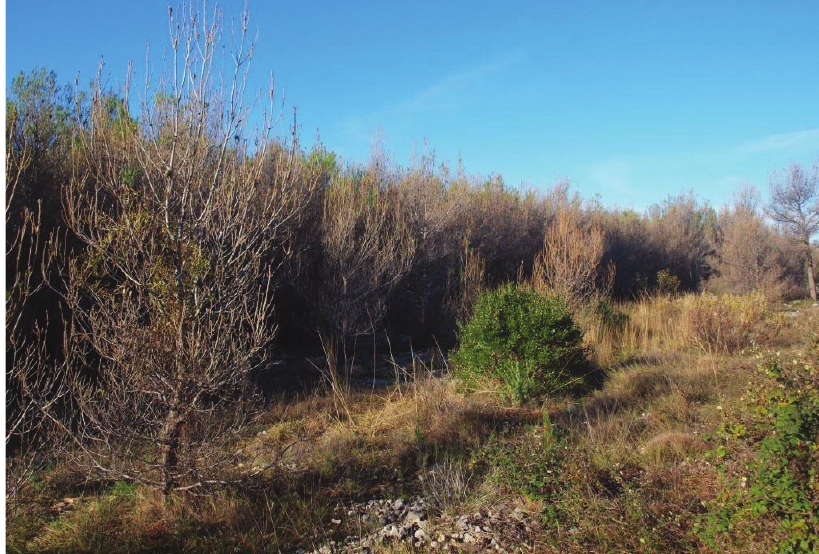
figUre 1. Dendrolimus pini outbreak in 2014 in Skradin,